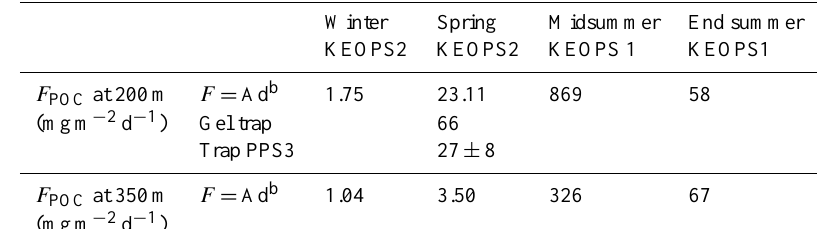
Table 3. Comparison of the POC fluxes ( F POC in mgm − 2 d − 1 ) derived from particle size distributions from the UVP, particle distributions from gel-filled sediment traps and sediment trap PPS3/3 Technicap Inc, France (Laurenceau et al., 2014) during KEOPS2 and KEOPS1 (Jouandet et al., 2011, Ebersbach and Trull, 2008).